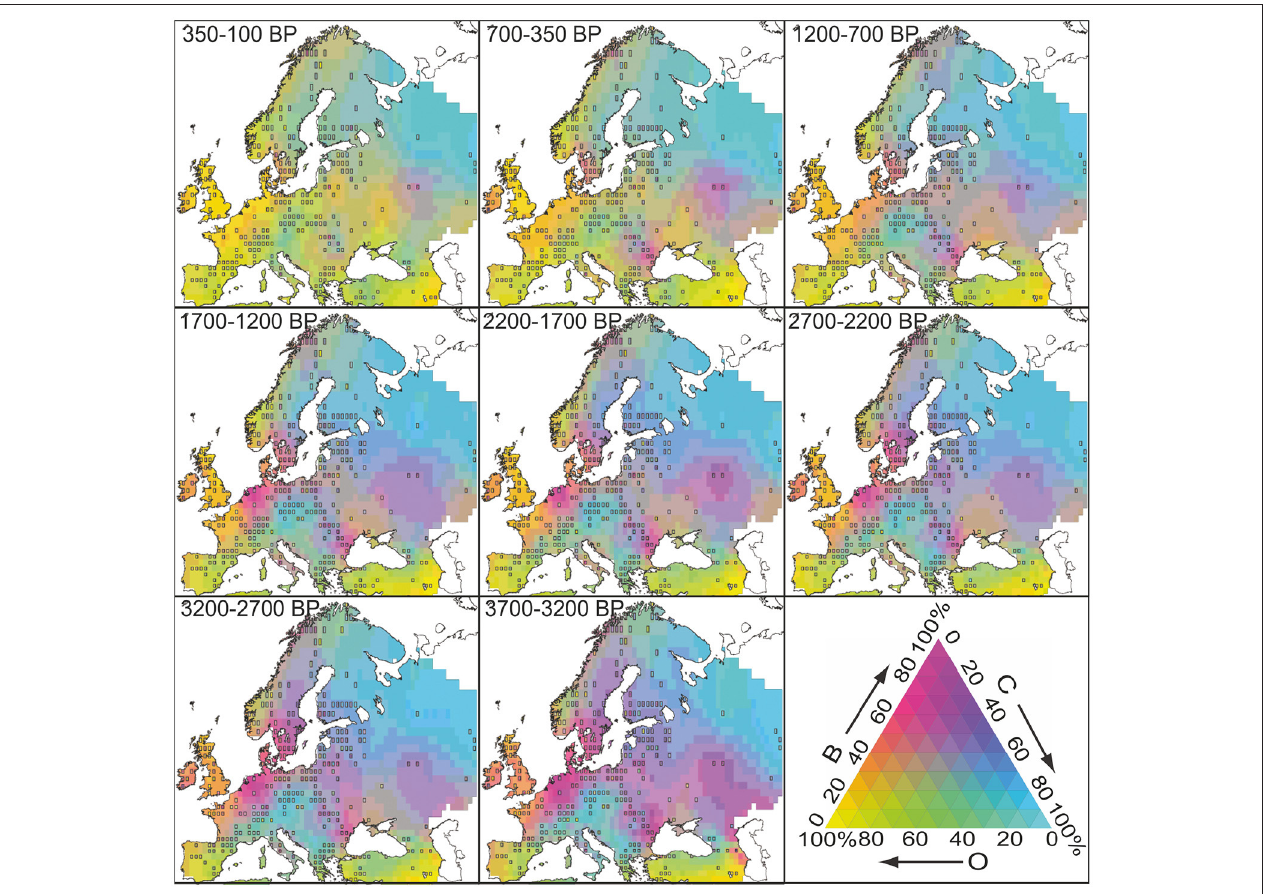
FIGURE 6 | Composite maps of reconstructed land cover for eight time-windows (3700–100 BP). The location of REVEALS estimates is marked by squares. The color-key for land-cover composition (C, coniferous forest; F, broad-leaved forest; O, open land) is presented as a triangular color